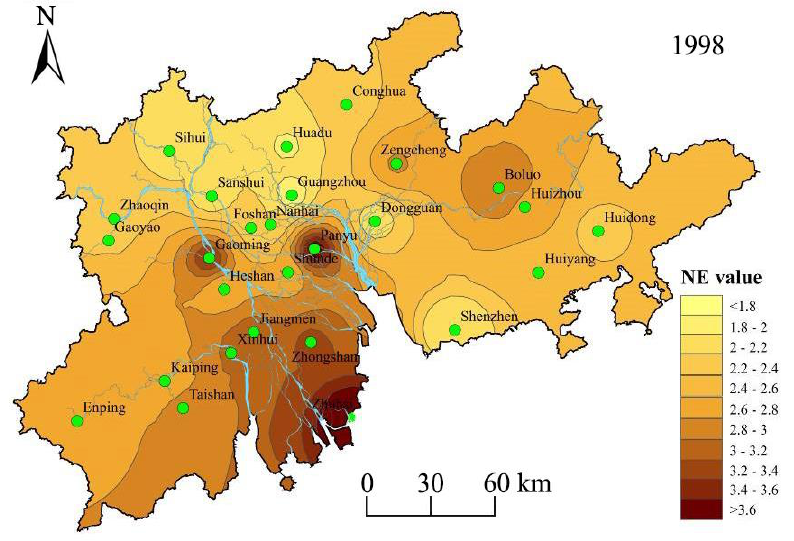
Figure 4b: The network efficiency (NE) of land-based transport network in the PRD, 1998